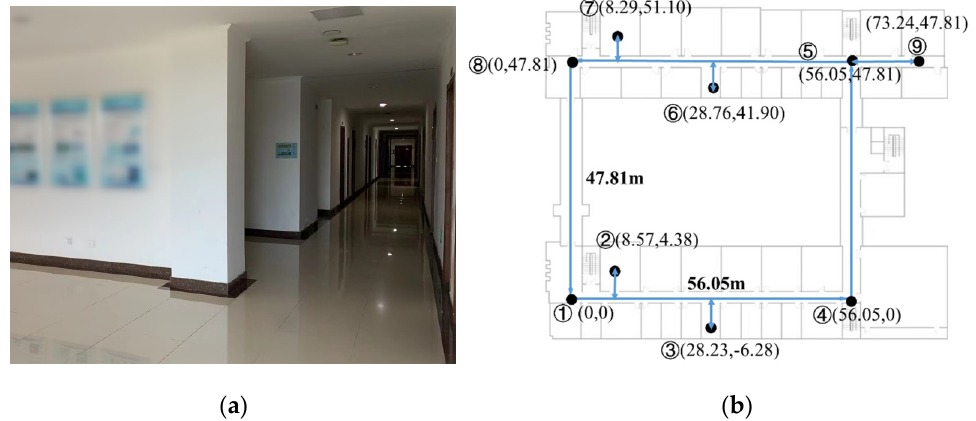
Table 5. Performance parameter of XSENS MTI-G-710 .